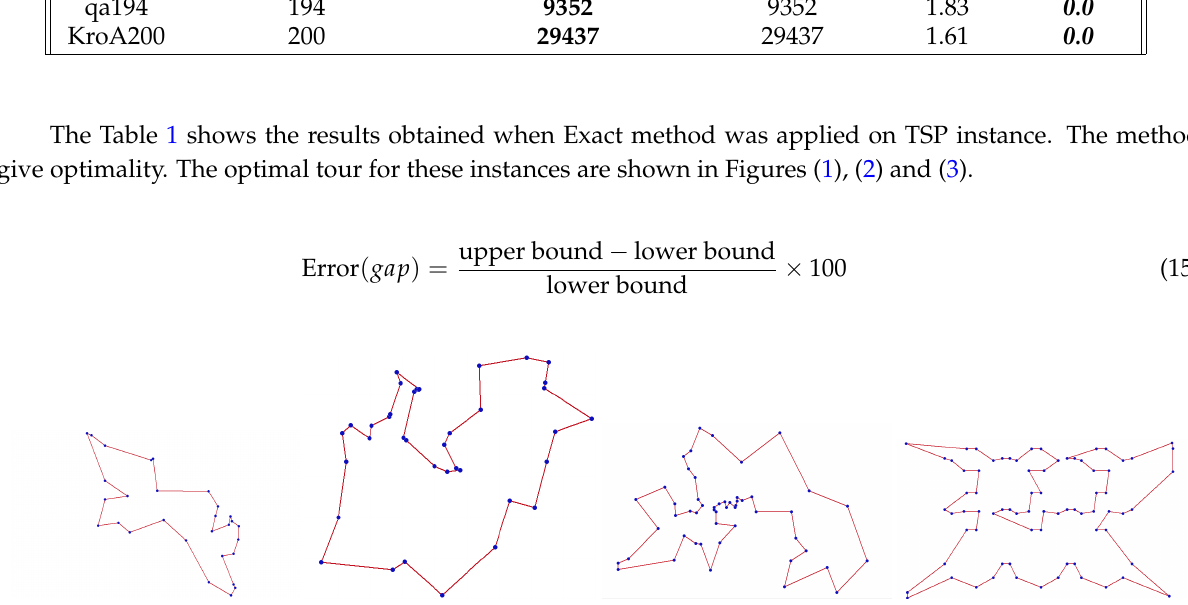
Figure 1. Optimal tour for WI29, DJ38, Berlin52 and pr76 instances, respectively